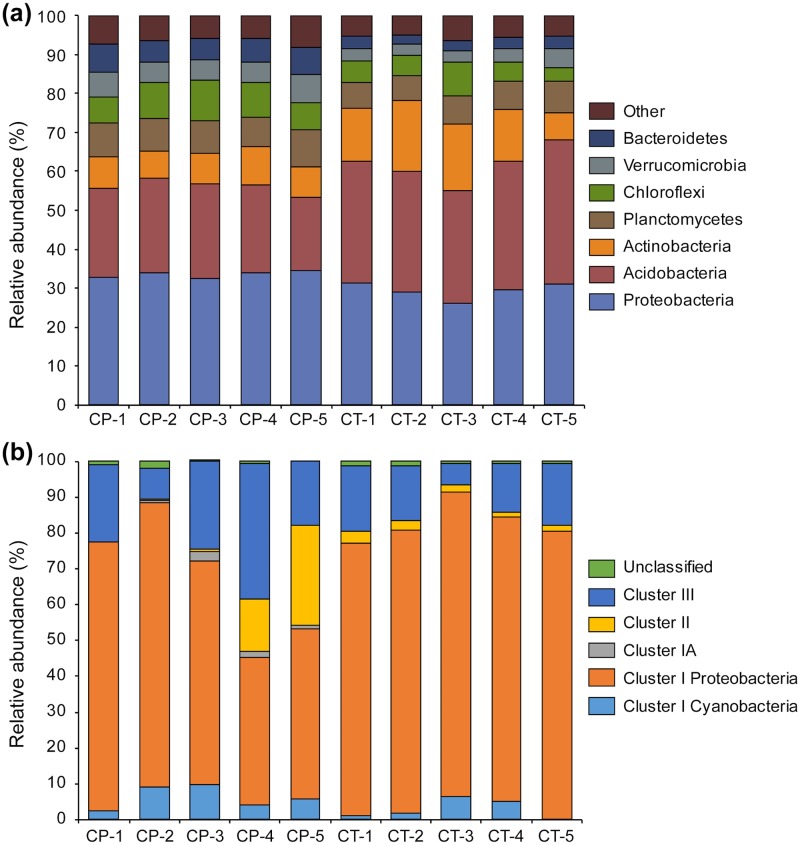
Taxonomic assignments of sequences from Chionochloa pallens (CP) and Chionochloa teretifolia (CT) grassland soils based on (a) 16S rRNA and (b) nifH gene sequences.Only dominant bacterial phyla (over 1%) of 16S rRNA gene sequences are shown. The nifH clusters are shown as previously designated [62].